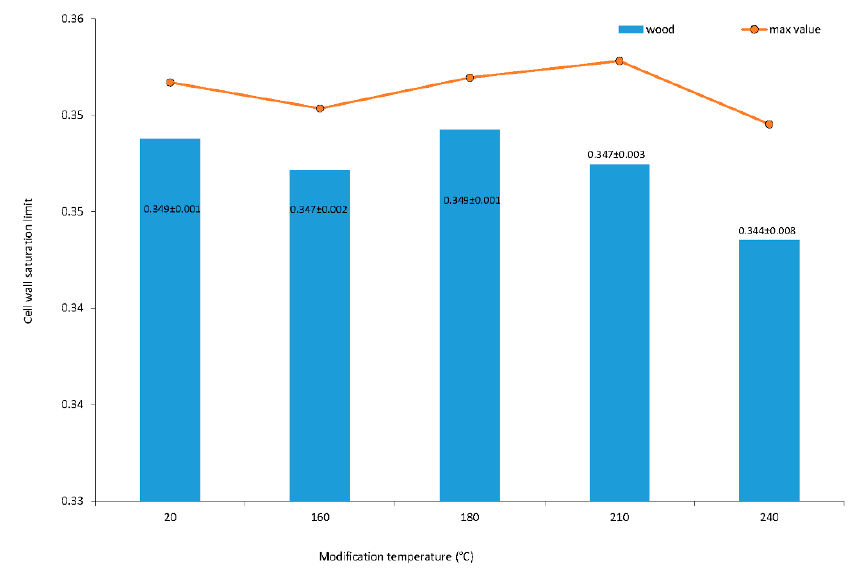
Figure 2. Average and maximum values of cell wall saturation limit of oak wood. Numbers following the averages are standard deviations from a measurement of 30 specimens.